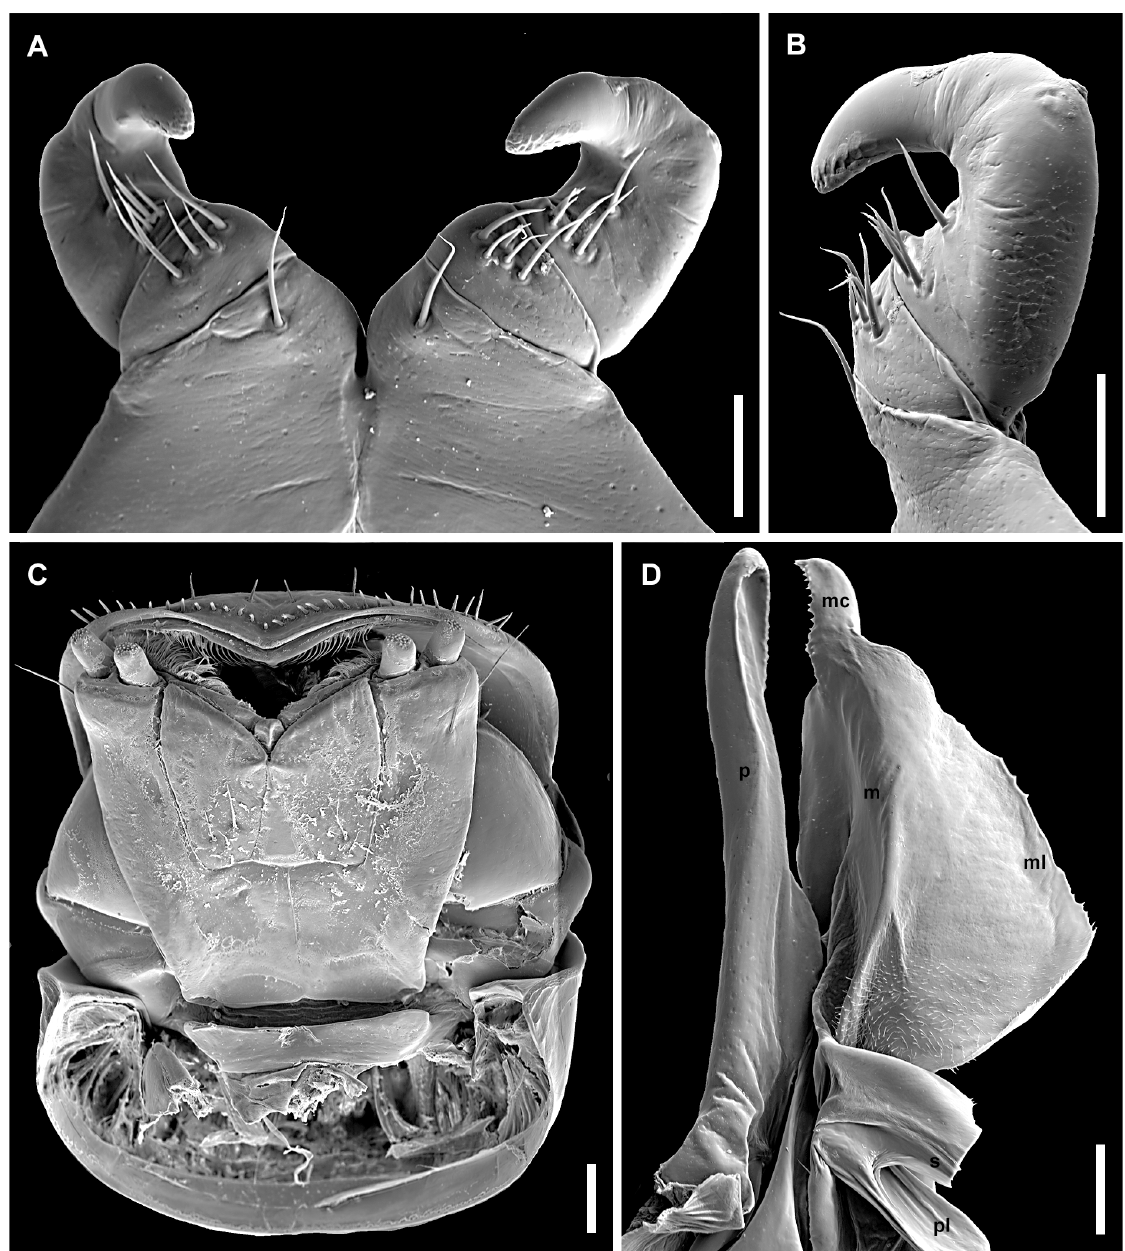
Fig. 45. Leucogeorgia redivivoides sp. nov., paratype ♂ from Nizhnyaya Shakuranskaya Cave (SMNG). A . Leg-pair 1, anterior view. B . Right leg 1, lateral view. C . Head, ventral view. D . Left gonopods,